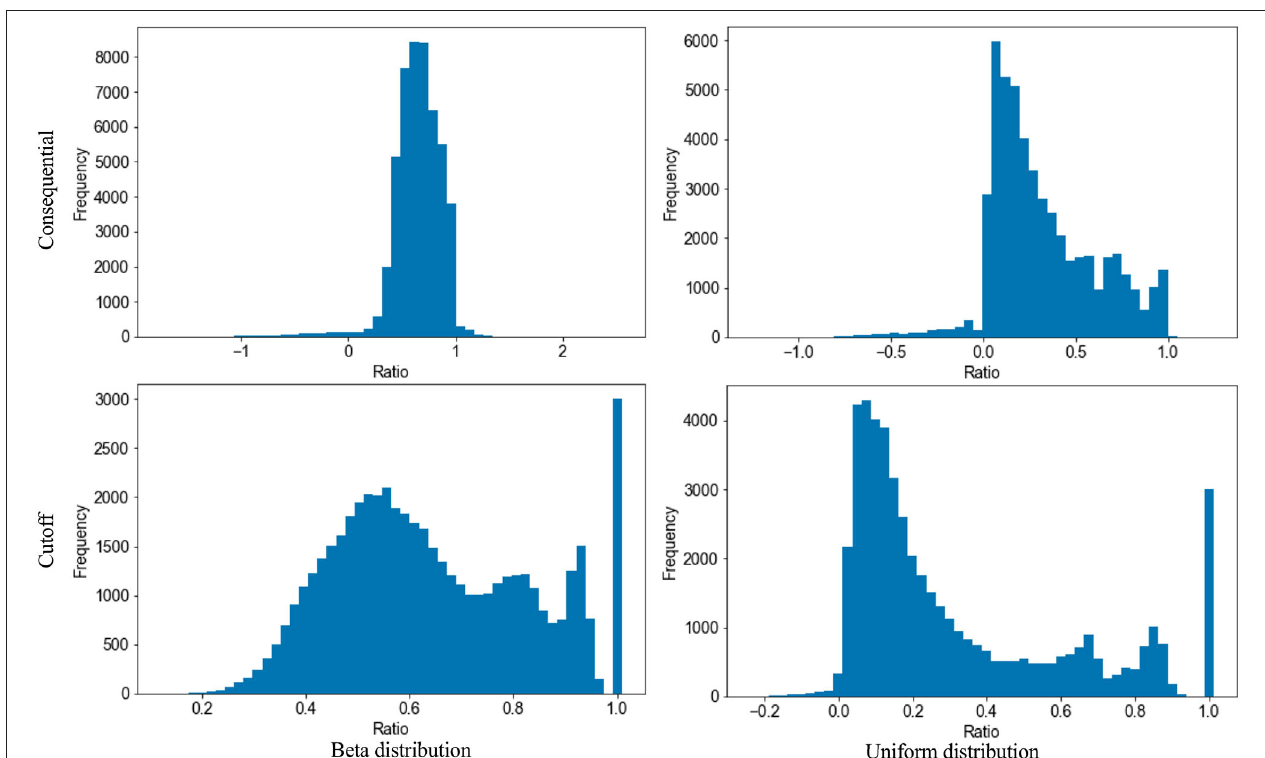
FIGURE 2 | Effect of efficiency improvements at database scale. The effect is obtained by randomly modifying the efficiency of all transformation activity datasets in the ecoinvent database and calculating the global warming impact for 50 randomly selected market activities. The effect is expressed as the ratio between the impact calculated using the improved datasets and the impact calculated using the unmodified dataset: values closer to 1 indicate a weaker effect. The efficiency improvement is performed on the technosphere matrix only and the values of the efficiency improvement are randomly selected using a uniform and beta distribution, respectively, and in both the cut-off and consequential system models of the ecoinvent